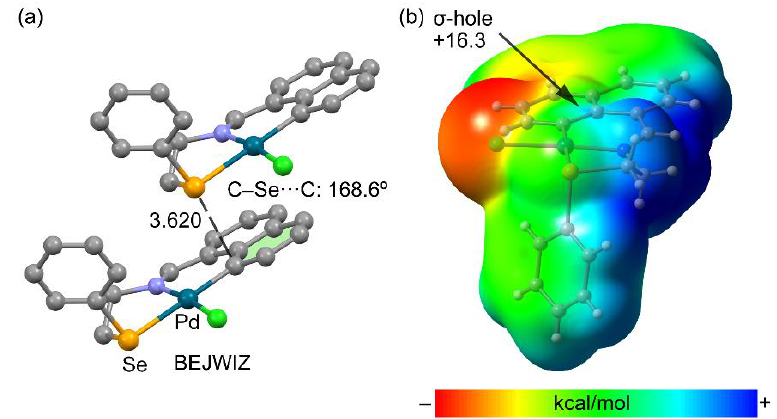
Figure 7. ( a ) Partial view of refcode BEJWIZ structure. Distance in Å . H-atoms omitted for clarity. ( b ) MEP surface (isodensity 0.001 a.u.) of BEJWIZ. The energies at the σ -holes are indicated in kcal/mol.